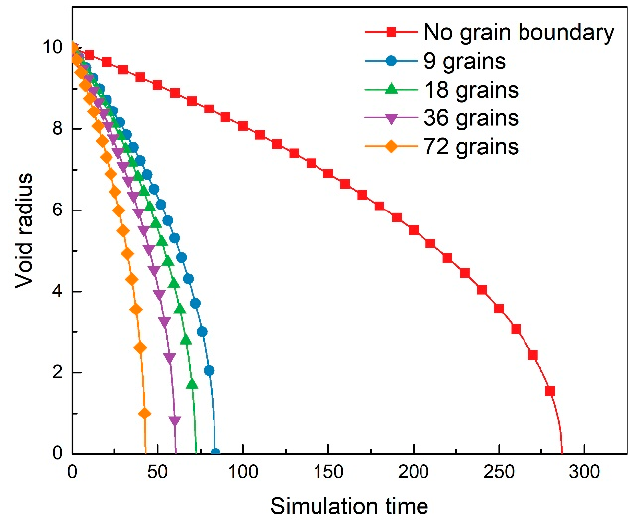
Figure 9. Effect of the number of grains in the simulation domain on the evolution of voids. Since the phase-field method uses dimensionless parameters, the simulation results in Figure 9 are also dimensionless. The evolution of the deformed void with simulation times is shown in Figure 10. As seen from the Figure 10, the deformed void starts to shrink inward from the long axis until the length of the long and short axes is the same, when it starts to decrease evenly. This is because the deformed void surface has a curvature difference, and the driving force generated by the curvature difference makes the long axis healing rate faster. The effect of the void long-to-short axial ratio on the void healing rate is shown in the Figure 11. It can be seen from Figure 11 that the healing rate of the void with a larger long-to-short axial ratio is faster, indicating that the void with larger deformation is healing faster.